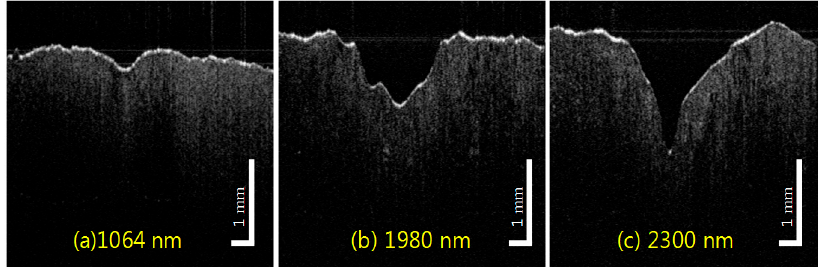
Figure 5. Representative OCT images of craters from laser irradiation at wavelength 1064 nm ( a ); 1980 nm ( b ); and 2300 nm ( c ) with 15 s ablation time. These particular images resulted from laser irradiation using a 400 micron multimode silica fiber at 10 W for pump (total energy delivery of 119.4 kJ/cm 2 ) and 1 W for signal and idler (total energy delivery of 11.9 kJ/cm 2 ).